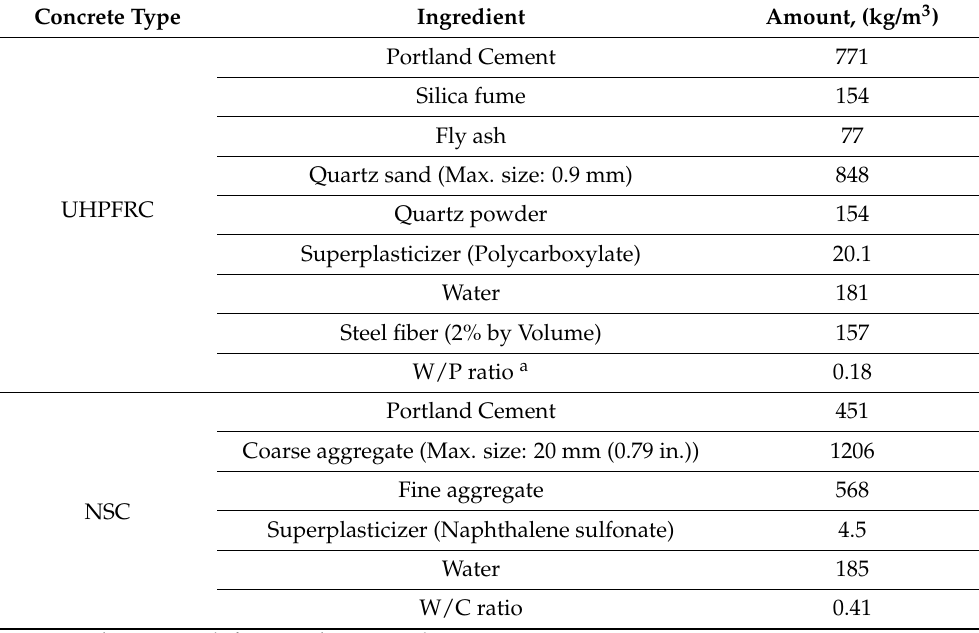
Table 1. Mix proportions for UHPFRC and NSC.